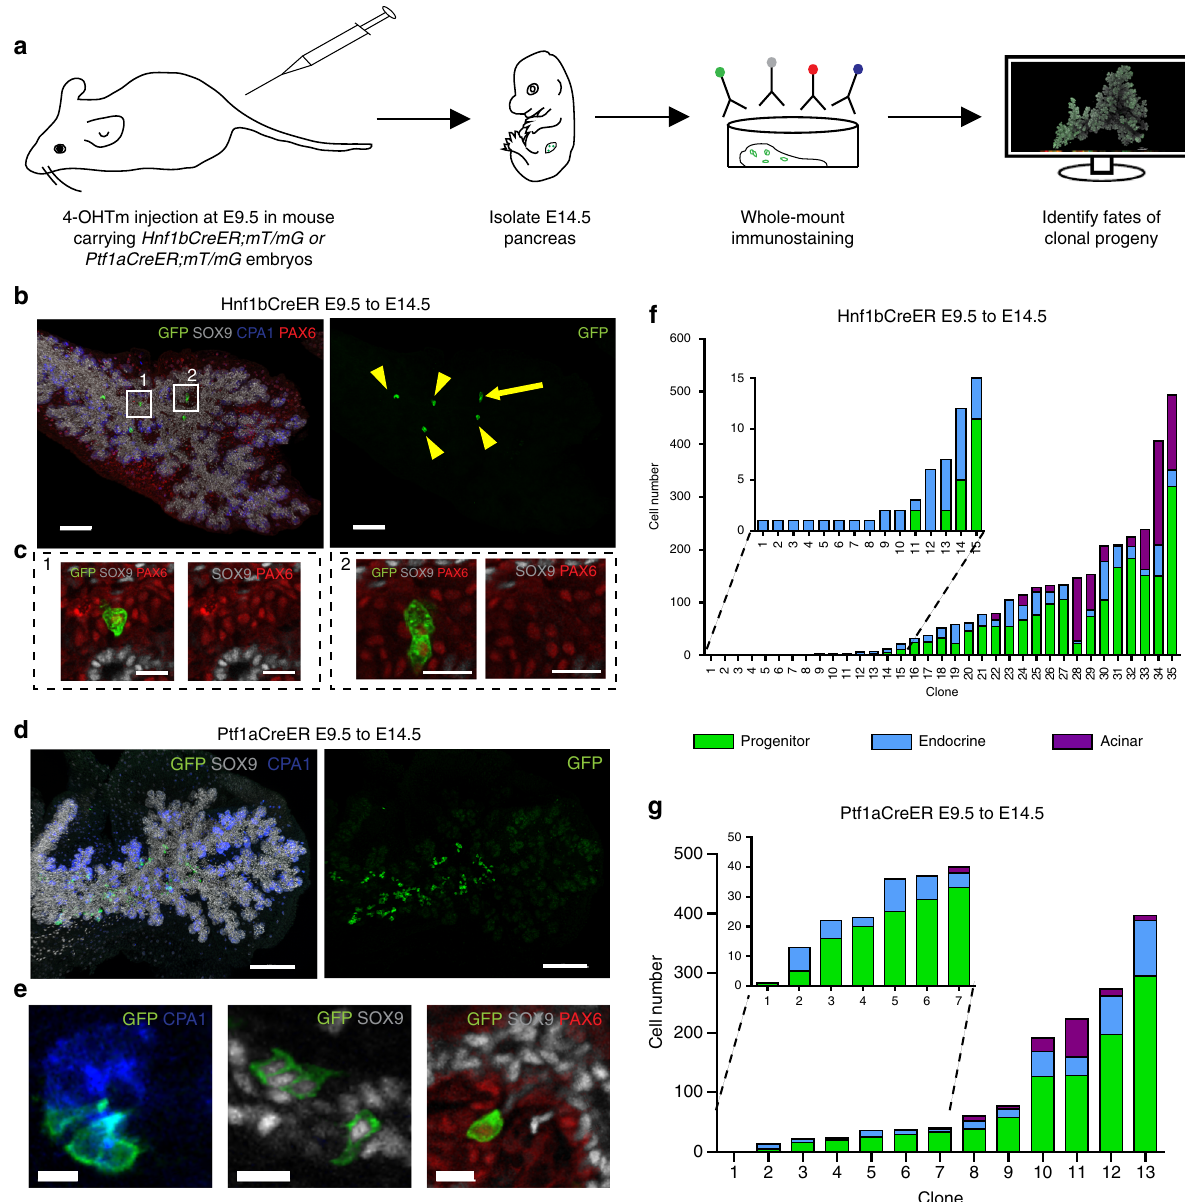
Fig. 4 Hnf1b CreER - and Ptf1a CreER -mediated clonal analysis con fi rms the existence of ducto-endocrine bipotent clones and the absence of unipotent acinar progenitors at E9.5. a Schematic overview of strategy applied to identify fates of clonal progeny from E9.5 pancreatic progenitors. b 3D MIP and high-magni fi cation optical sections ( c ) of clonal progeny from a unipotent endocrine clone containing six labelled endocrine PAX6 + endocrine cells generated by Hnf1b CreER -mediated clonal analysis. Arrow indicates two juxtaposed GFP + cells, whereas arrowheads indicate single GFP-labelled cells. Scale bars, 100 µ m b and 15 µ m c . d 3D MIP and high-magni fi cation optical sections ( e ) of a multipotent clone derived from Ptf1a CreER -mediated lineage tracing. Scale bars, 150 µ m d and 15 µ m e . f , g Quanti fi cation of clone sizes and fate compositions following Hnf1b CreER - and Ptf1a CreER -mediated clonal analysis, respectively ( n = 120 embryos for Hnf1b CreER and 34 embryos for Ptf1aCreER- the images displayed show representative data from those). Note that clone no. 1 contains only one cell and is only SOX9 + . Most clones were found in the dorsal pancreas, except clones no. 14, 17, 18, 26, 33 in f and clones no. 3, 8, 9 in g which were found in the ventral